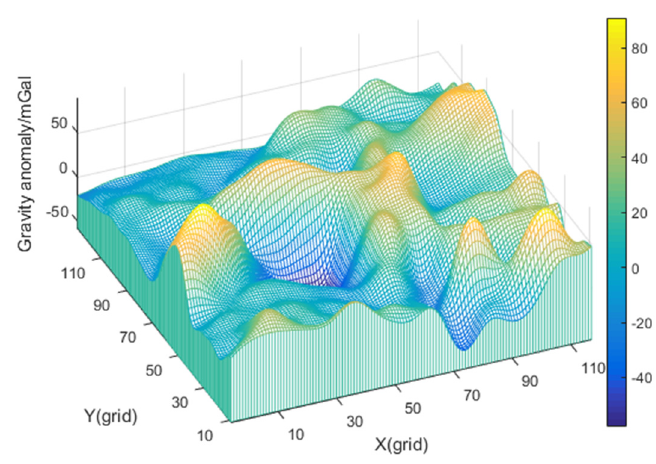
Figure 4. The distribution of gravity field of track 1.